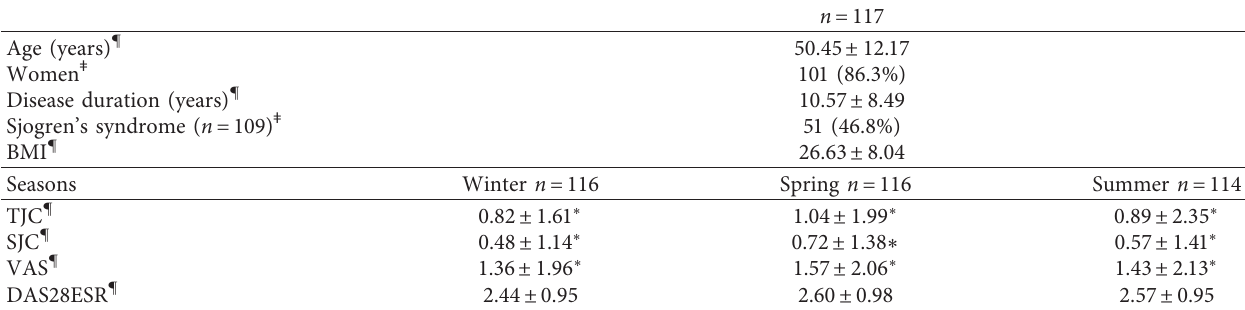
Table 2: Descriptive data of the population.